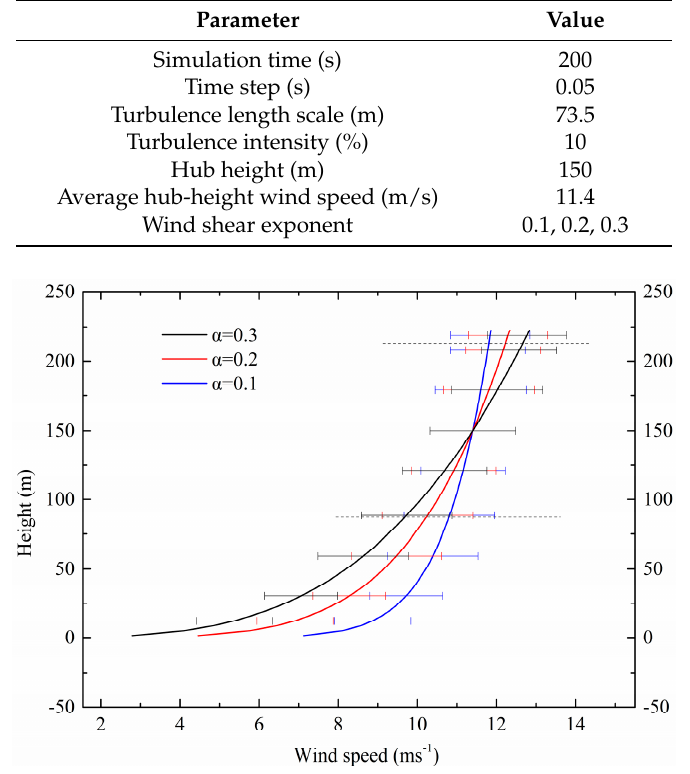
Figure 1. The variations in the simulated time-averaged (200 s) horizontal wind speed (left) and wind direction (right) with low-level jet (LLJ) height above the ground of ( a ) 87 m, ( b ) 119 m, ( c ) 150 m, ( d ) 181 m, and ( e ) 213 m. The error bars represent standard deviation of the mean. The horizontal dotted lines above and below represent the height of the top-tip and bottom-tip of the rotor, respectively.